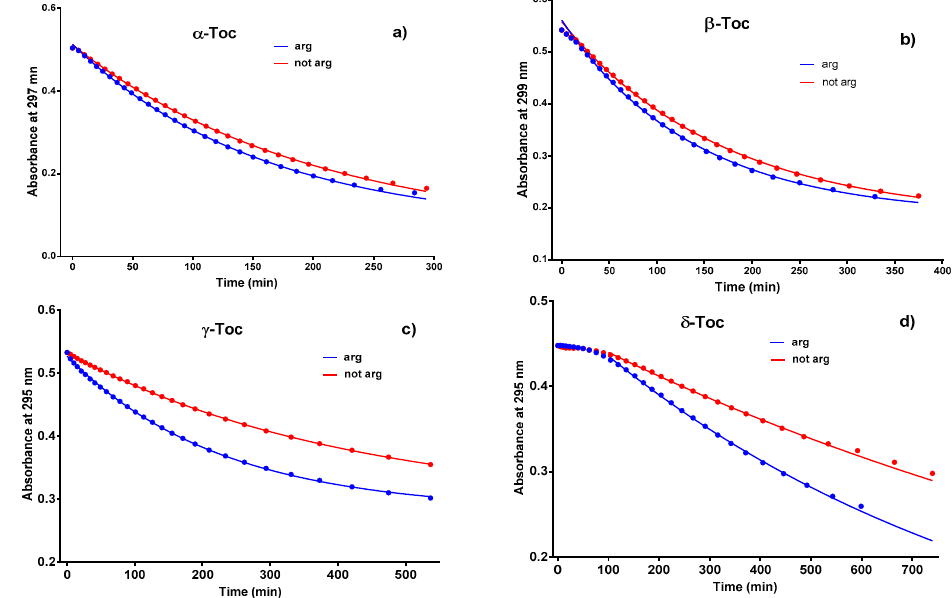
Figure 2. Time-course of absorbance at maximum of Tocs samples: argonated during irradiation—blue lines and non-argonated—red lines. One exponential decay function was used to fit experimental data.